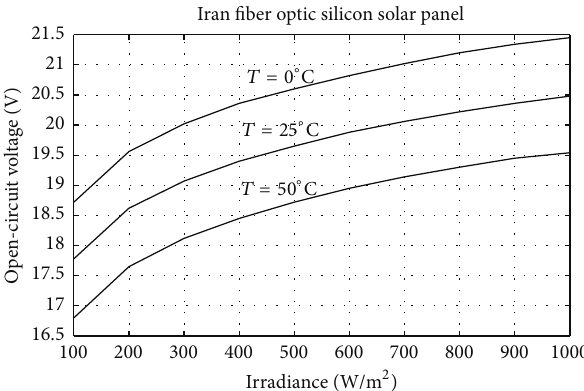
Figure 6: Open-circuit voltage of the solar panel under investiga- tion.